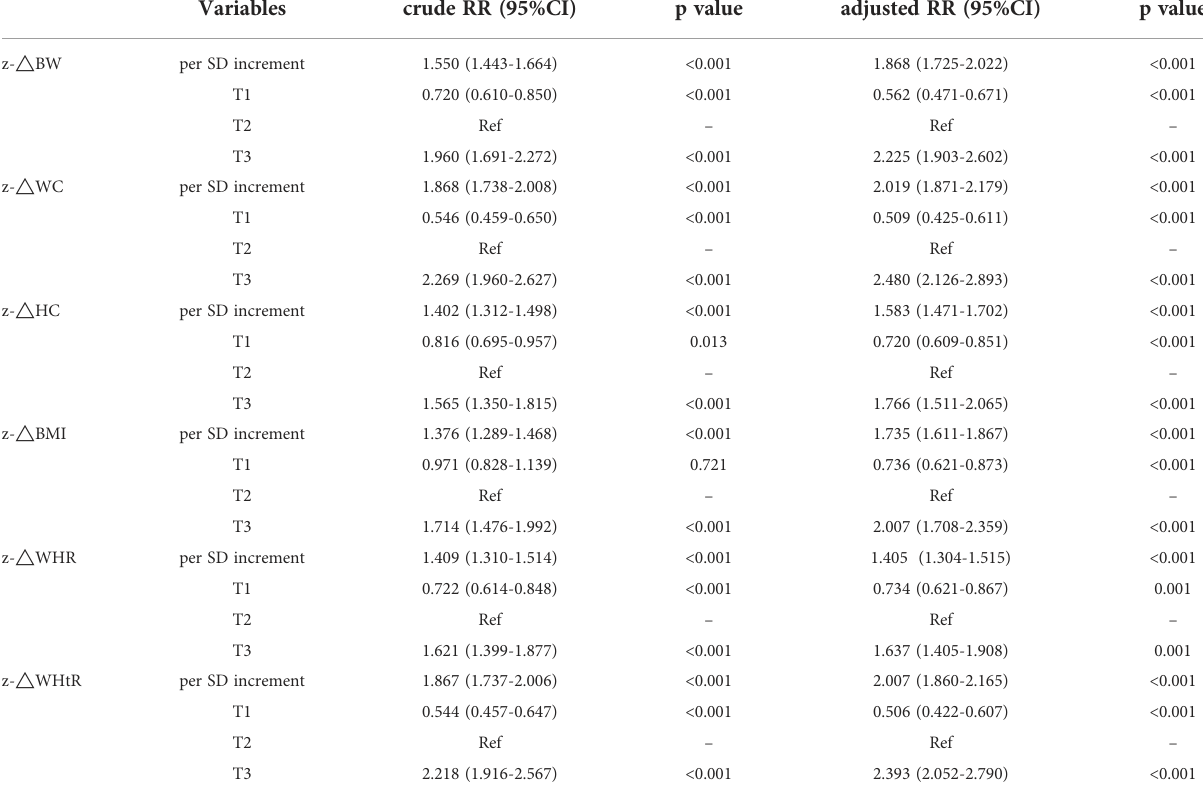
TABLE 2 Crude and multivariate-adjusted risk ratios and 95% con fi dence intervals of binary logistics regression model.